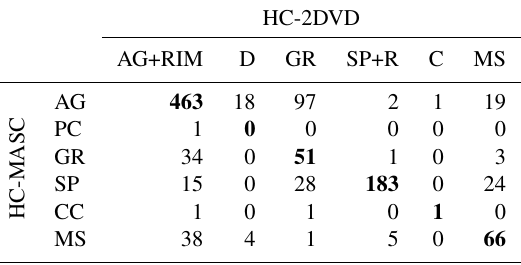
Table 3. Confusion matrix obtained by comparing MASC and 2DVD hydrometeor classification during winter 2015–2016 in Davos (Switzerland). Each entry in the matrix corresponds to the dominant hydrometeor type recorded during an interval of 5min measured by both instruments. For HC-2DVD, rain and small par- ticles have been merged (SP+R), as well as rimed particles and ag- gregates (AG+RIM),